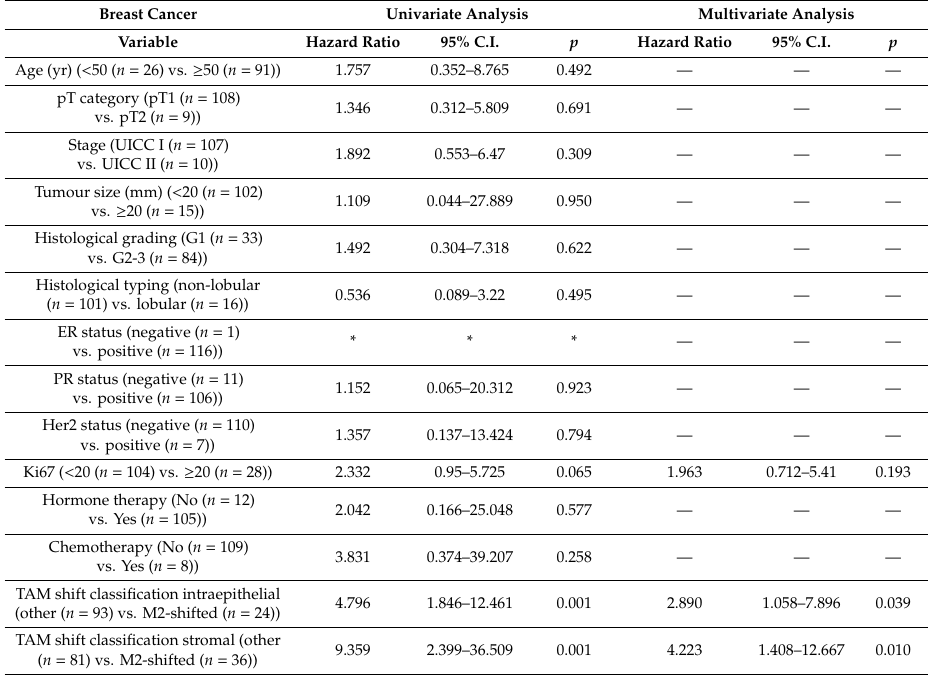
Table 4. Univariate and multivariate analysis of disease-free survival according to Cox’s proportional hazards model. Parameters marked with an asterisk were not included in calculations because group sizes were not comparable.